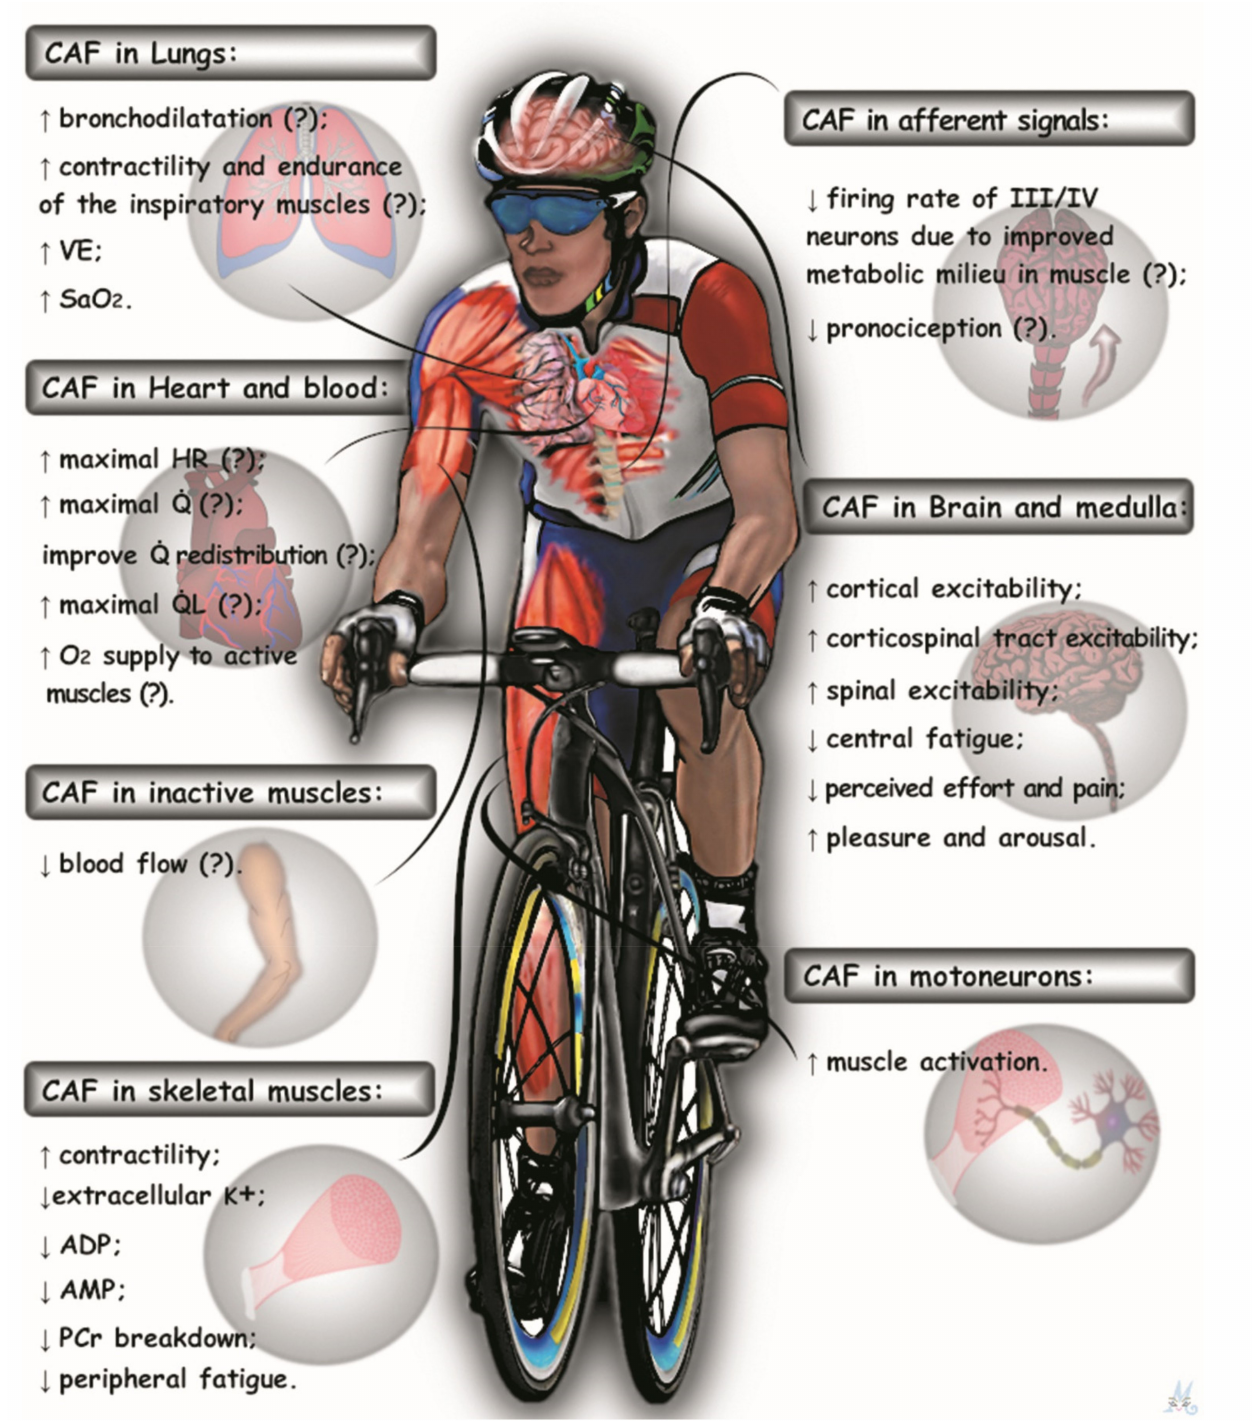
Figure 6. An illustration of the integrative approach to the effects of caffeine (CAF) on multiple physiological systems. Together, such alterations may better explain the improvements in endurance performance during high-intensity whole- . V E: pulmonary ventilation. S a O 2 : arterial oxygen saturation. HR: heart rate. body exercise. flow. K + : extracellular potassium. ADP: adenosine diphosphate. AMP: adenosine monophosphate. PCr: